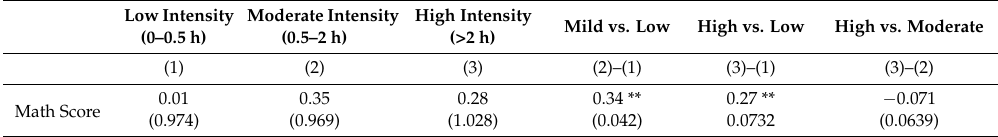
Table A3. Summary of student baseline math scores, by after-class study hours.